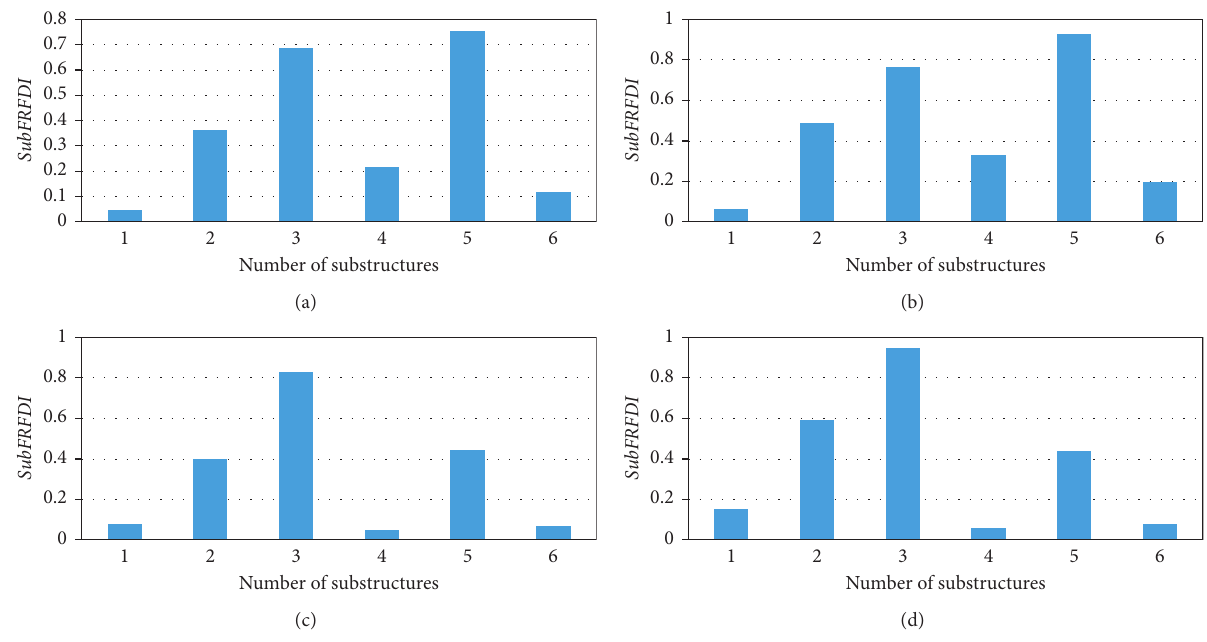
Figure 14: SubFRFDI values for (a) case Dam_3F10%&5F15%, (b) case Dam_3F10%&5F20%, (c) case Dam_3F15%&5F10%, and (d) case